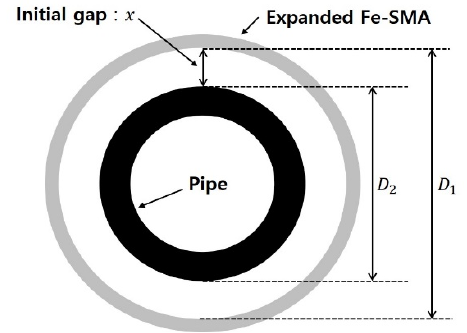
Figure 14. Pipe joining process by Fe ‐ SMA coupler.